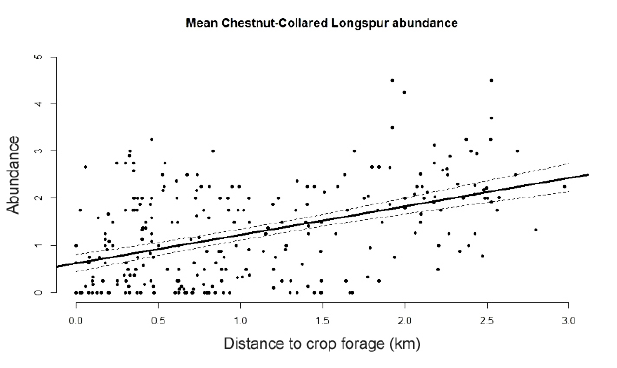
Fig. 2 . Effect of distance to cropland/forage on Chestnut- collared Longspur ( Calcarius ornatus ) relative abundance in southern Alberta, Canada, 2000-2002. Figure produced using R graphing software (R Core Team